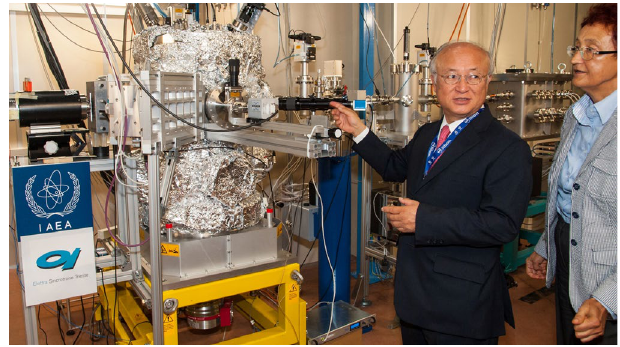
Fig. 4. IAEA Director General Yukiya Amano during the inauguration of the new XRF beamline at EST, in October 2014. (Photo: EST)